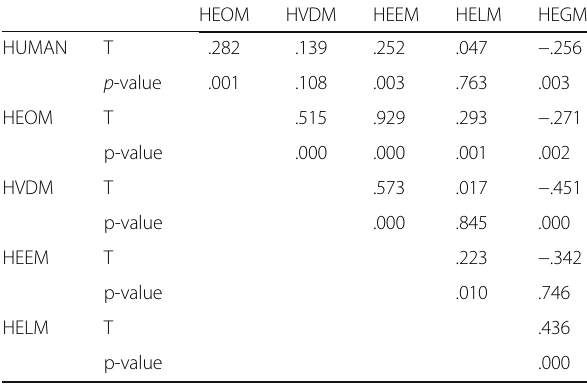
Table 5 Kendall Tau Rank Correlation Coefficients